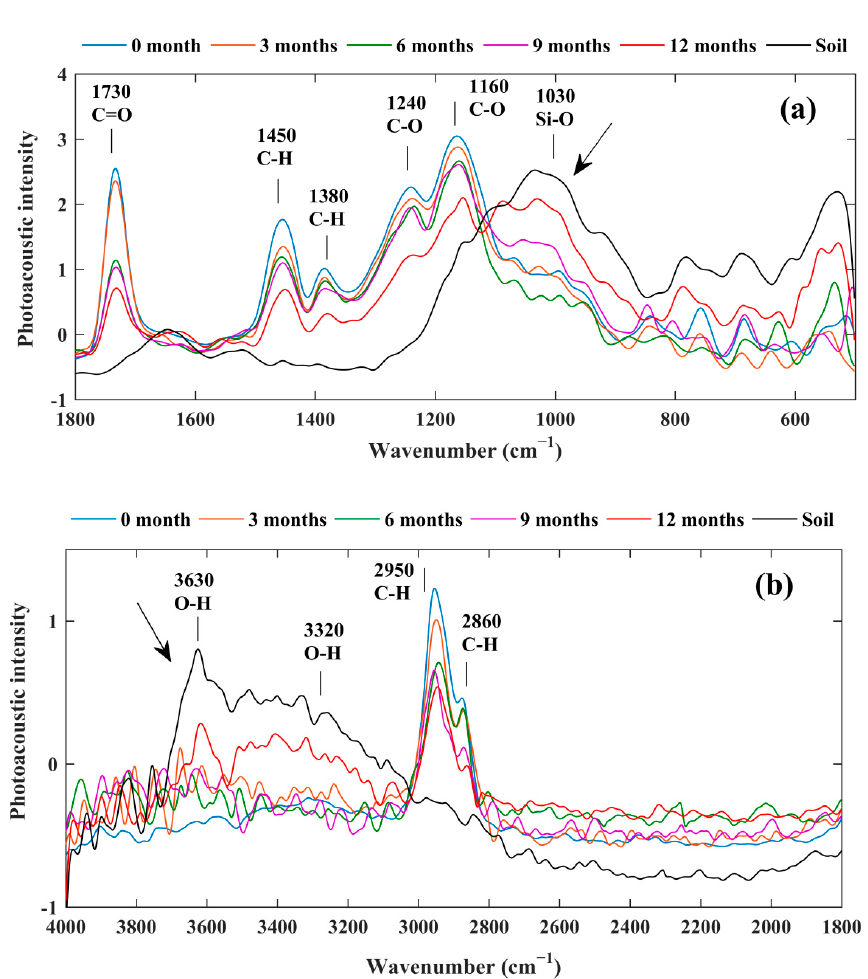
Figure 3. Average FTIR-PAS spectra of PA films and soil in the wavenumber ranges of 500–1800 cm − 1 ( a ) and 1800–4000 cm − 1 ( b ).